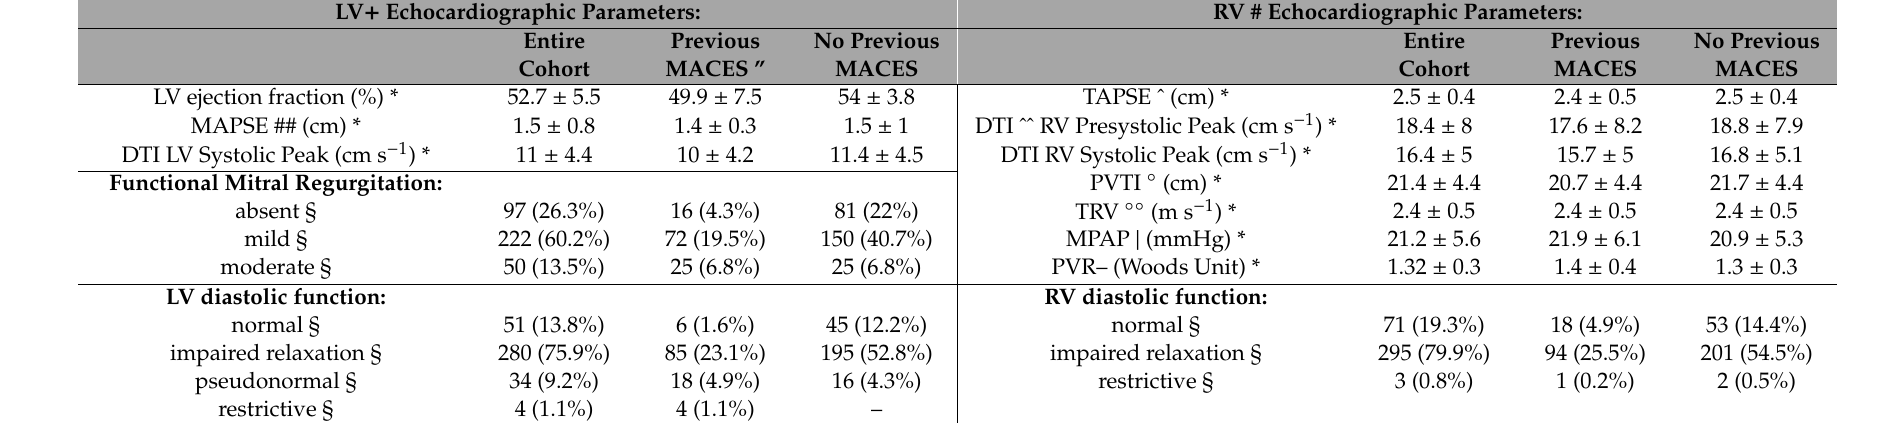
Table 2. Mean values and frequencies of the estimated ultrasound